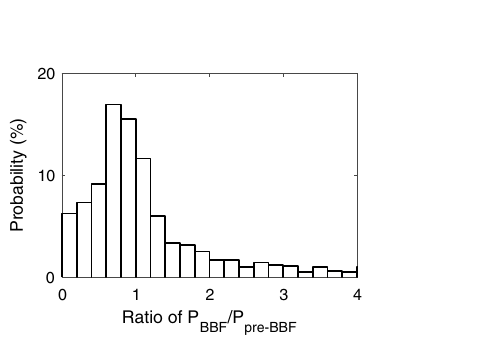
Figure 4. Ratio of P BBF to P BPS